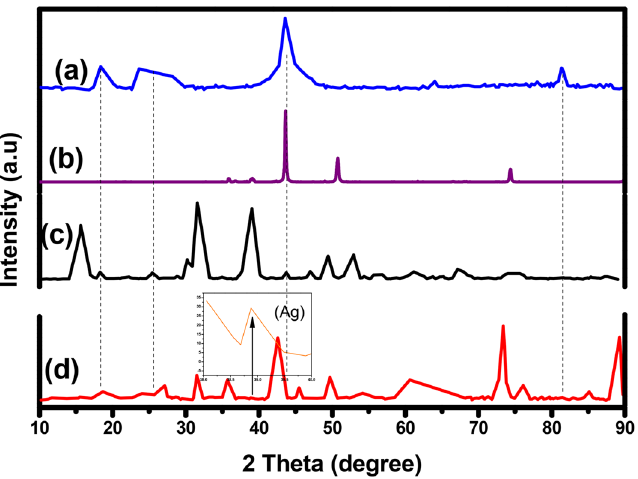
Figure 2. XRD patterns of (a) Cu 2 O (b) TANI (c) TANI/Cu 2 O and (d) TANI/Cu 2 O/Ag.